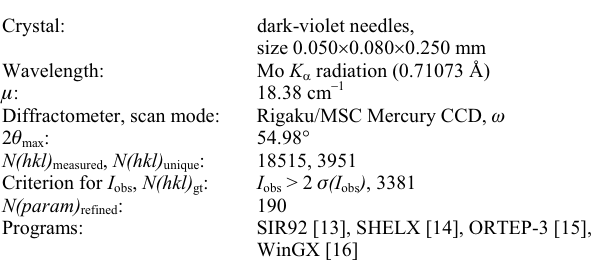
Table 1. Data collection and handling.